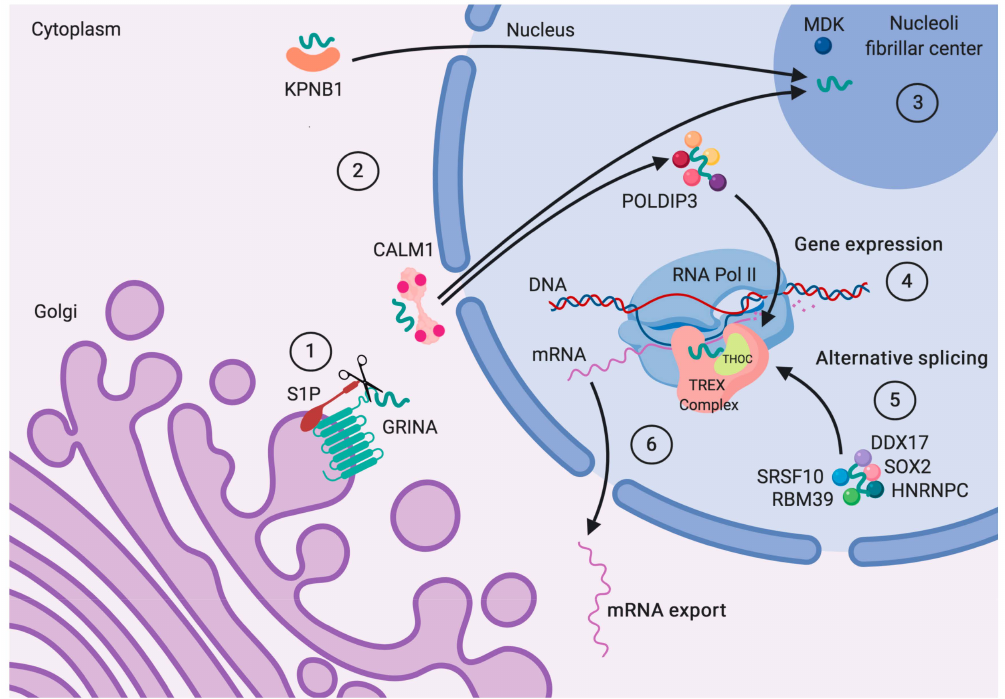
Figure 5. A model for the nuclear localization of GRINA. (1) Under appropriate conditions the N-terminal side of GRINA may be cleaved by S1P or Nardilysin. (2) Then, it may be able to enter